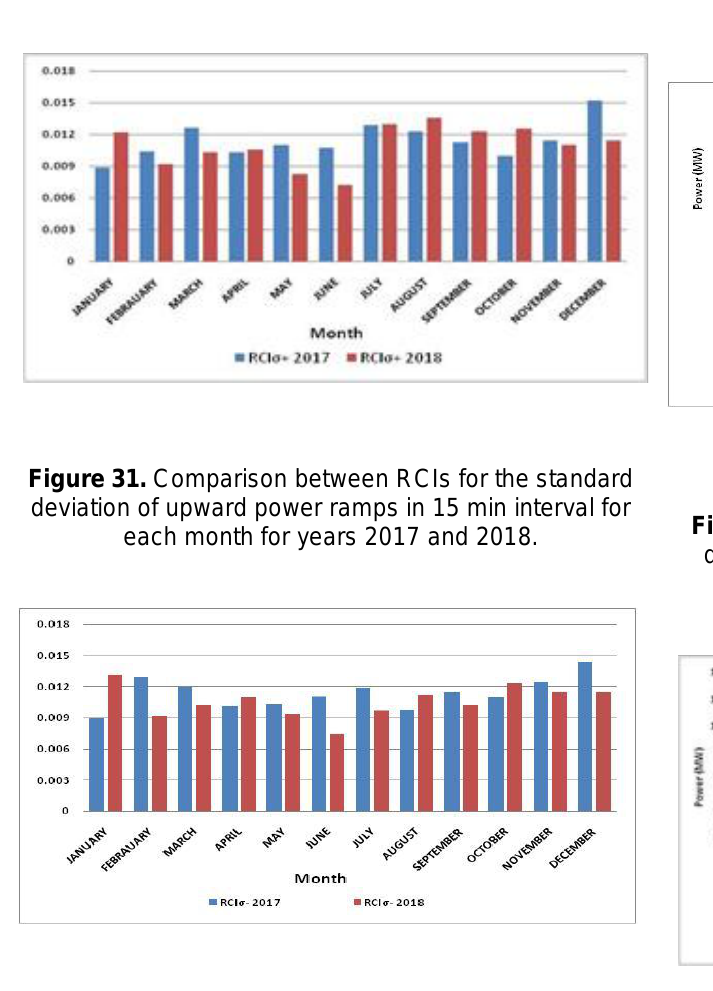
Figure 30. Comparison between standard deviation values of downward power ramps in 15 min interval for each month for years 2017 and 2018.